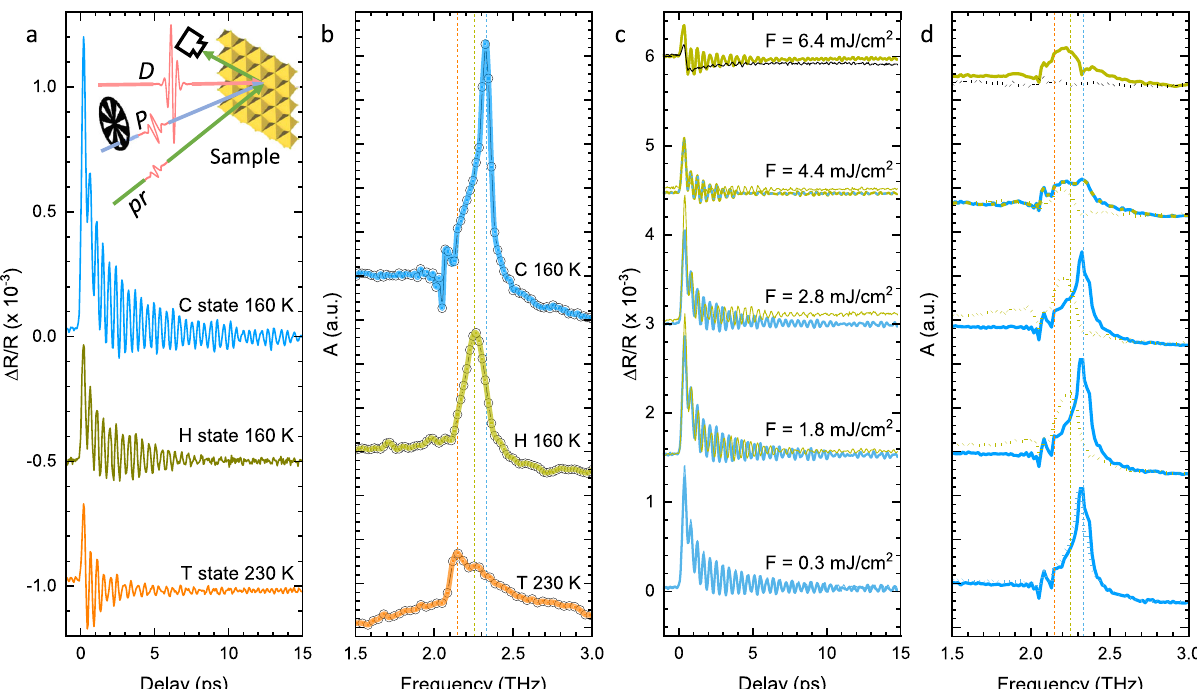
Fig. 2 Transient re fl ectivity data. a , b The transient re fl ectivity oscillations and their Fourier spectra for commensurate, hidden, and triclinic (C, H, and T) state, measured with three-pulse (C and H states) and two-pulse (T state) technique. The inset in ( a ) shows the schematic of the setup. The vertical dashed lines in ( b ) mark the peaks and are also shown in ( d ) for comparison. c Three-pulse drive-pump-probe (D – P – p) transient re fl ectivity measurements for different fl uences at 30 ps (bold lines) and 1 ms (thin lines) showing different transition outcomes at 160 K, ( d ) their respective Fourier transforms. The bold and dotted spectra correspond to the measurements at 30-ps and 1-ms,